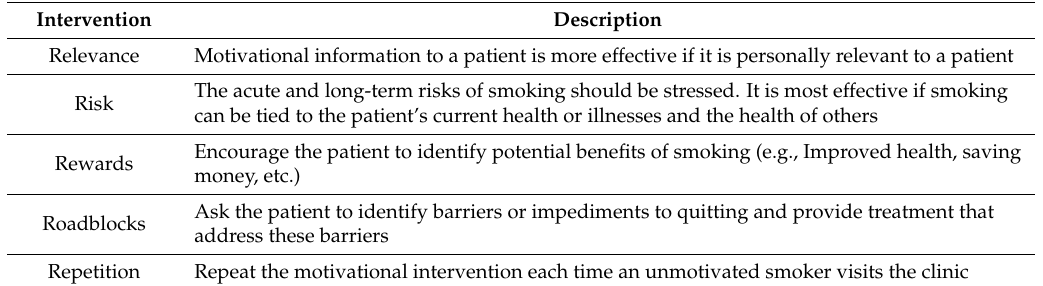
Table 4. Enhancing motivation to quit tobacco—The “5 R’s”